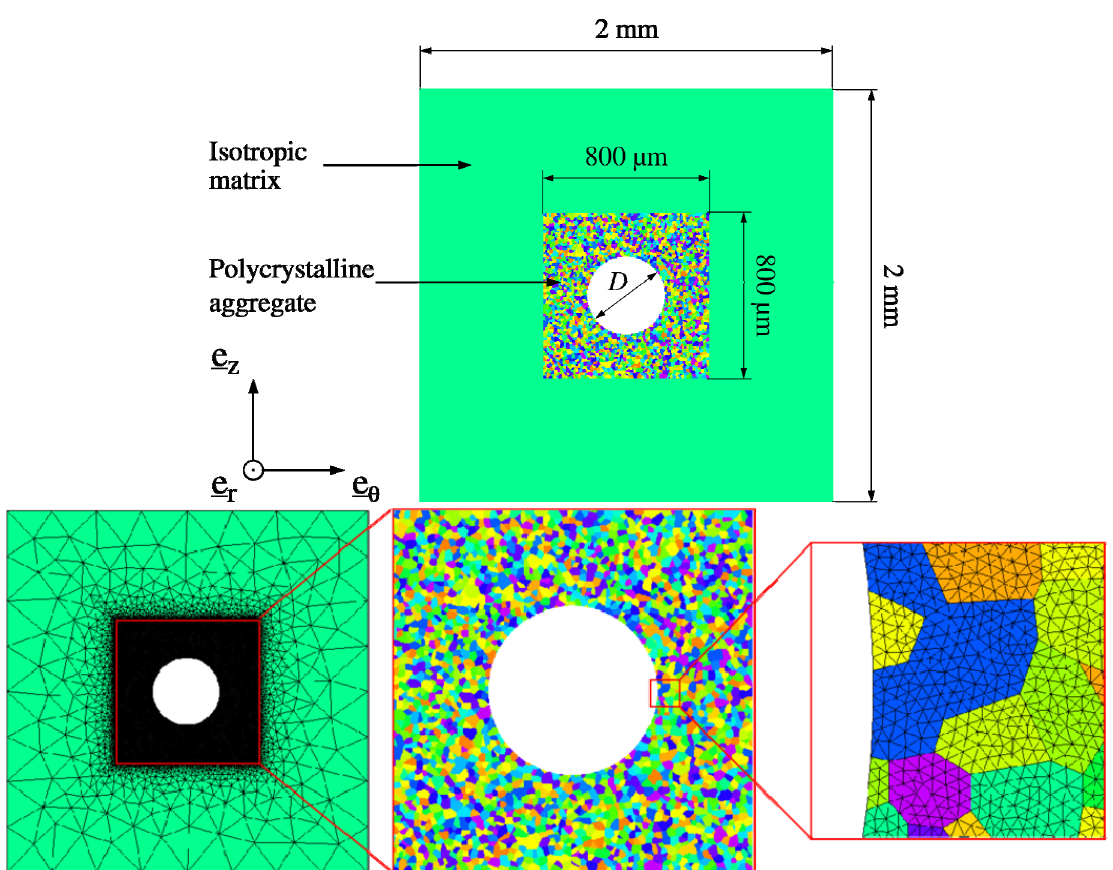
Figure 1: Shape and dimensions of the polycrystalline aggregate and the matrix used in the 2D finite element model. Constitutive material models at the mesoscopic (grain) scale and probabilistic criterion To represent the behavior of each individual grain of the 316L polycrystalline aggregate, an elasto-visco-plastic constitutive material model is used. For the FCC structure under interest, the elastic behavior is cubic and the plastic slip occurs along the closed-packed planes {1 1 1} and directions <1 1 0>. Cubic elasticity is assigned to each grain and is characterized by three coefficients defined in the crystal coordinate system: C 1111 , C 1122 and C 1212 . A